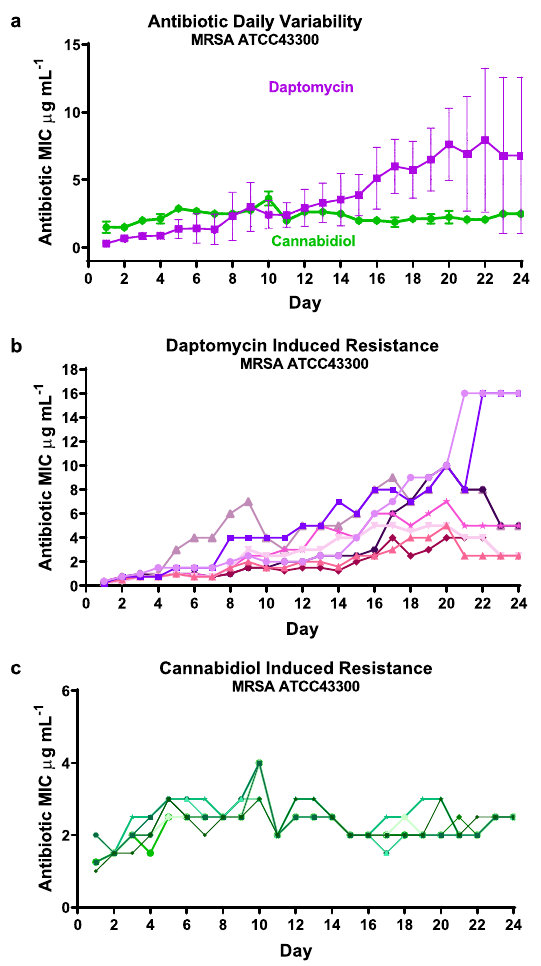
Fig. 3 Broth dilution serial passage resistance induction studies. a Average daily MIC during exposure of MRSA (ATCC 43300) to sublethal concentrations of daptomycin or CBD over 20 days of bacterial growth, followed by 5 days without antibiotic exposure. Data are mean ± SEM for n = 8 biologically independent samples. b , c The corresponding individual replicates for the two compounds (drug-free from Day Finally, bacterial cytological pro fi ling (BCP) gave results (Fig. 4d – g) consistent with previously published BCP results for other antibiotics known to act by membrane permeabilization 36 – 38 .